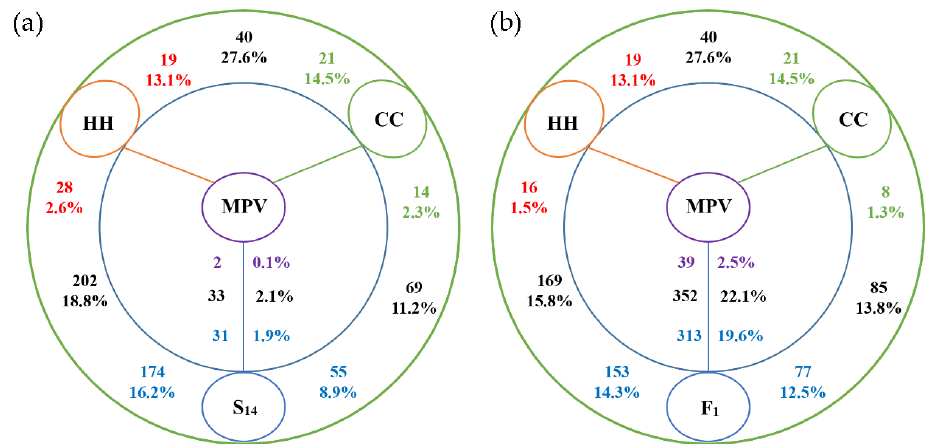
Figure 4. lncRNA genes differentially expressed in S 14 (a) / F 1 (b) progeny and their diploid (HH, CC) progenitors. Numbers close to the species (colored) represent upregulated lncRNAs compared with the neighboring species. Percentages indicate those among all expressed lncRNAs. The total number of lncRNAs differentially expressed between the two species is given (black) .